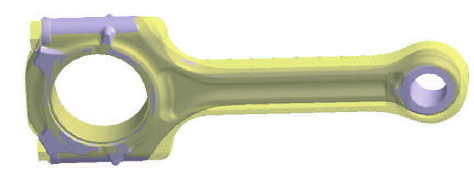
Fig. 7. Geometric changes between model 1 (gray) and model 2 (yellow)